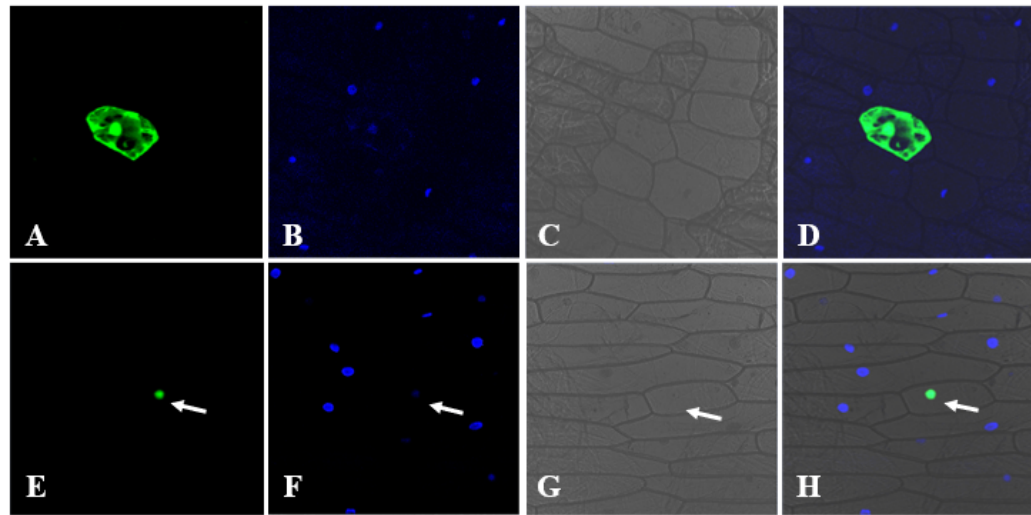
Figure 2. Subcellular localization of PsnCYCD1;1. The 35S::PsnCYCD1;1-GFP fusion vectors were transiently expressed in onion epidermal cells with 35S::GFP vectors as control. The photographs were taken in dark field for green fluorescence ( A , E ), with DAPI signal ( B , F ), in bright light to examine cellular morphology ( C , G ), and in combination ( D , H ). The cells transiently expressed the GFP control ( A – D ) and PsnCYCD1;1-GFP fusion protein ( E – H ).